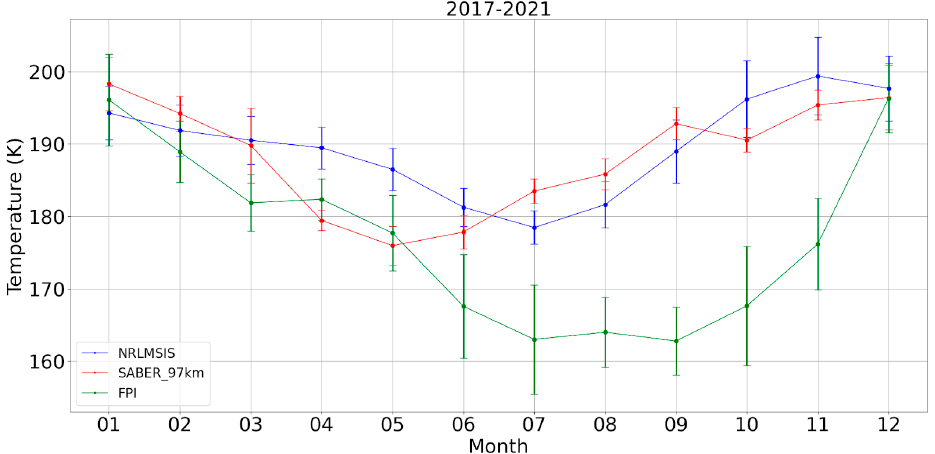
Figure 4. Monthly average effective temperatures and deviations from 2017 to 2021 from SABER (red), FPI (green) and NRLMSIS model (blue) data.